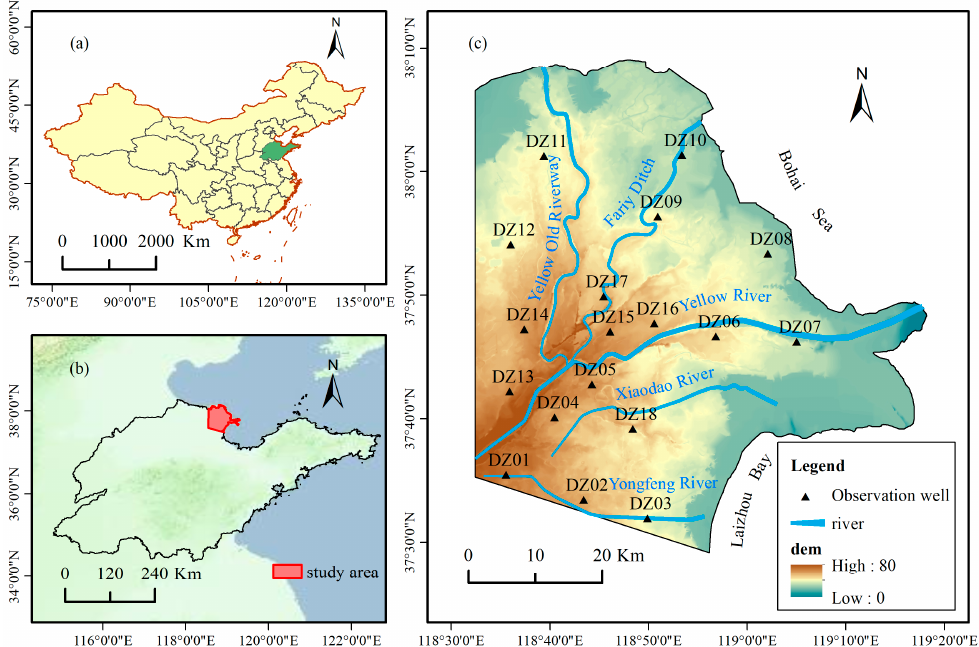
Figure 1. Study area description: ( a ) Shandong Province in the map of China; ( b ) location of the Yellow River Delta in the map of Shandong Province; ( c ) the distribution of groundwater observation wells in the Yellow River Delta.